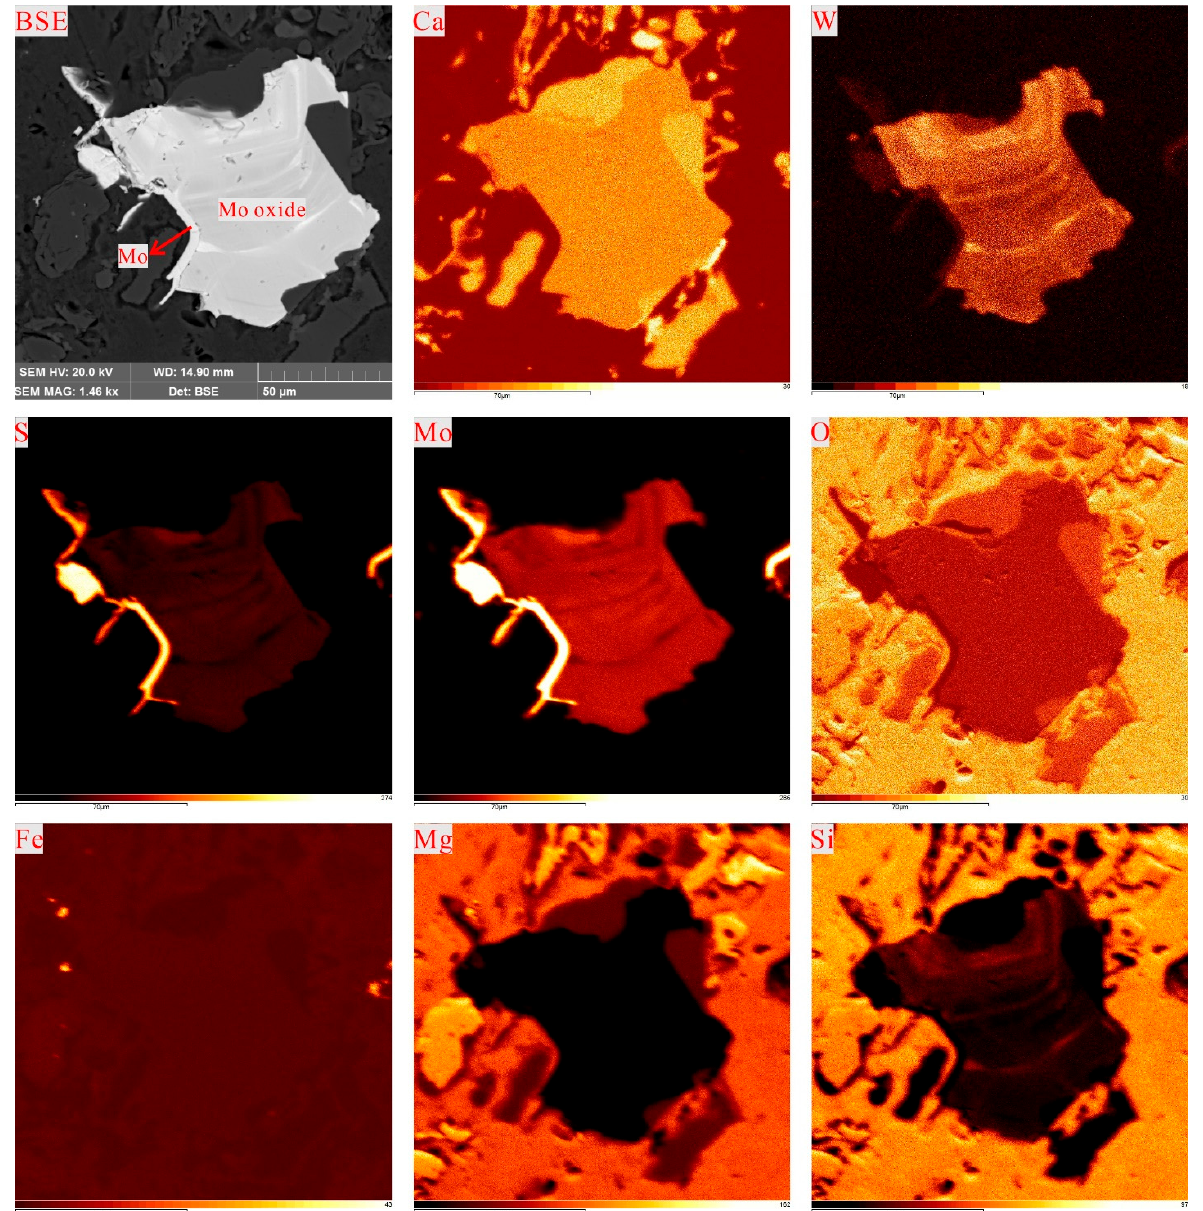
Figure 12. Mapping of the elements scanning results based on SEM. Abbreviation: Mo,